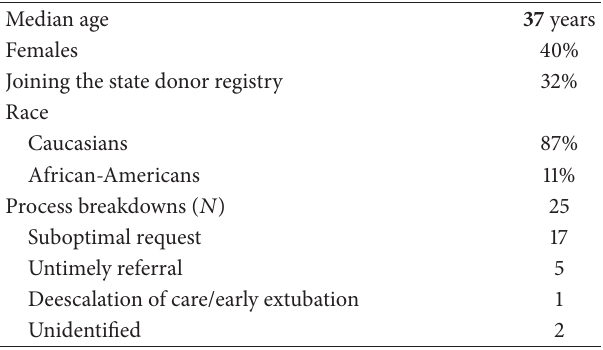
Table 2: Descriptive statistics for eligible deaths.